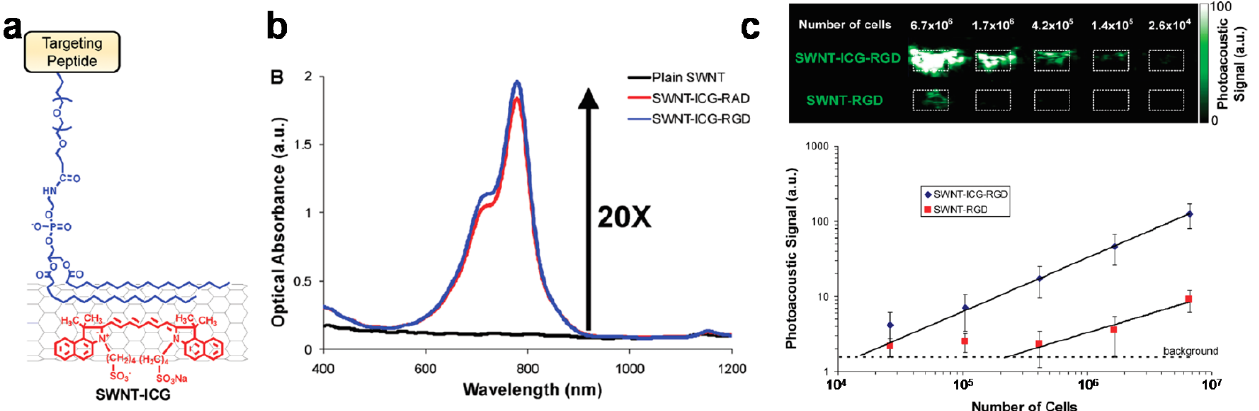
Figure 3. ( a ) Illustration of SWNT conjugated with ICG dye (SWNT-ICG). ( b ) Optical spectra of plain SWNT (black), SWNT-ICG-RGD (blue), and SWNT-ICG-RAD (red). ( c ) Photoacoustic image (upper) and quantitative photoacoustic signals (lower) from cancer cells exposed to SWNT-ICG-RGD and SWNT-RGD. Reprinted with permission from [70]. Copyright, American Chemical Society (2010).